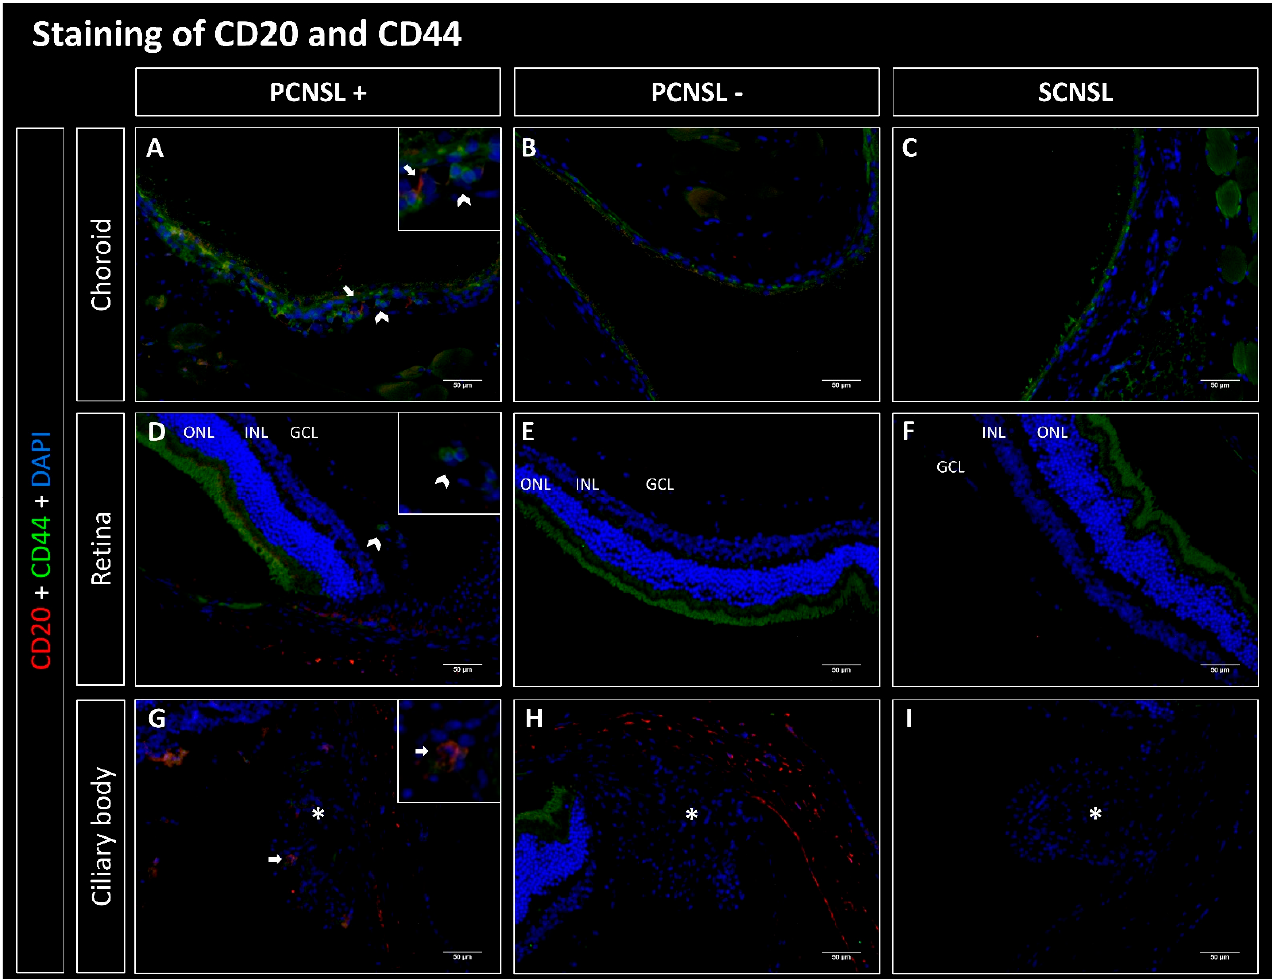
Figure 4. Fluorescence microscopy of CD20 (red) and CD44 (green) double staining of the eyes in the PDX PCNSL vs. PDX SCNSL group. ( A – C ) show recordings of the choroid, ( D – F ) of the retina and ( G – I ) of the ciliary body (marked with *). ( A , D , G ) show the choroids, retinas, and ciliary bodies infiltrated with CD20-positive primary CNS lymphoma cells (PCNSL+) (arrows). ( A ) shows CD44+ cells (chevron arrow), which are often located in capillaries near CD20-positive lymphoma cells. CD44+ cells were also seen in capillaries in the retina ( D ). Fewer CD44+ cells were found in the ciliary body. In the PCNSL negative (PCNSL-) group ( B , E , H ) and in the SCNSL group ( C , F , I ) no CD20+ and few CD44+ cells were found in the choroid, retina and ciliary body. ONL = outer nuclear layer, INL = inner nuclear layer, GCL = ganglion cell layer; scale bar 50 µm.